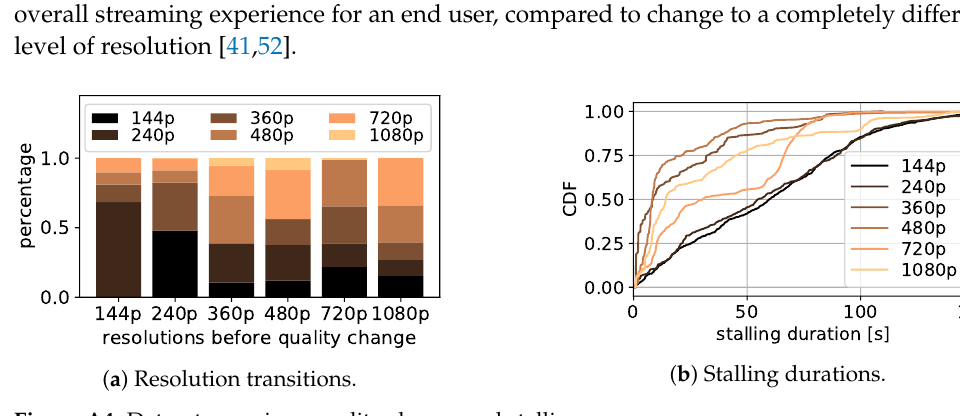
Figure A4. Dataset overview: quality change and